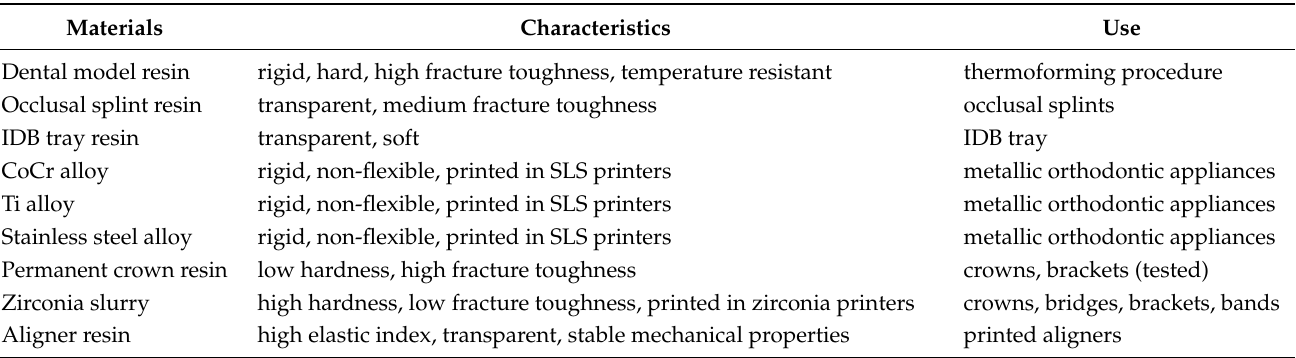
Table 1. Three-dimensional printing materials used in Orthodontic and pedodontic appliances.